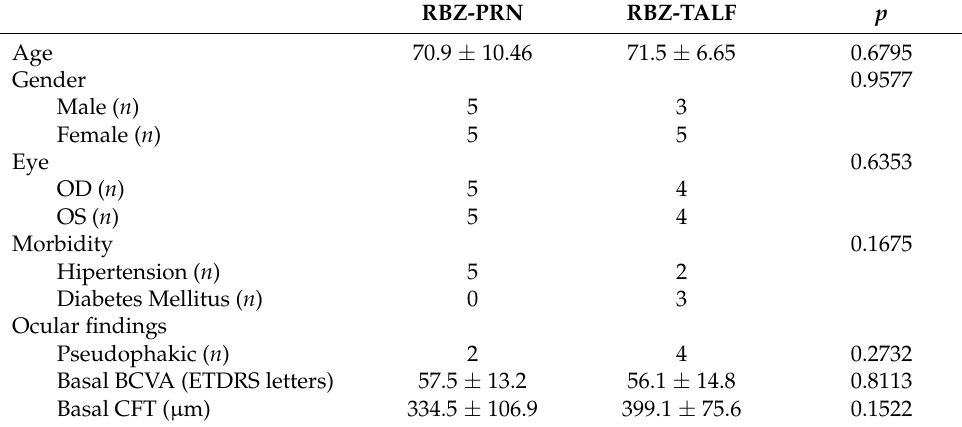
Table 1. Demographic and clinical characteristics of the patients and their study eyes.